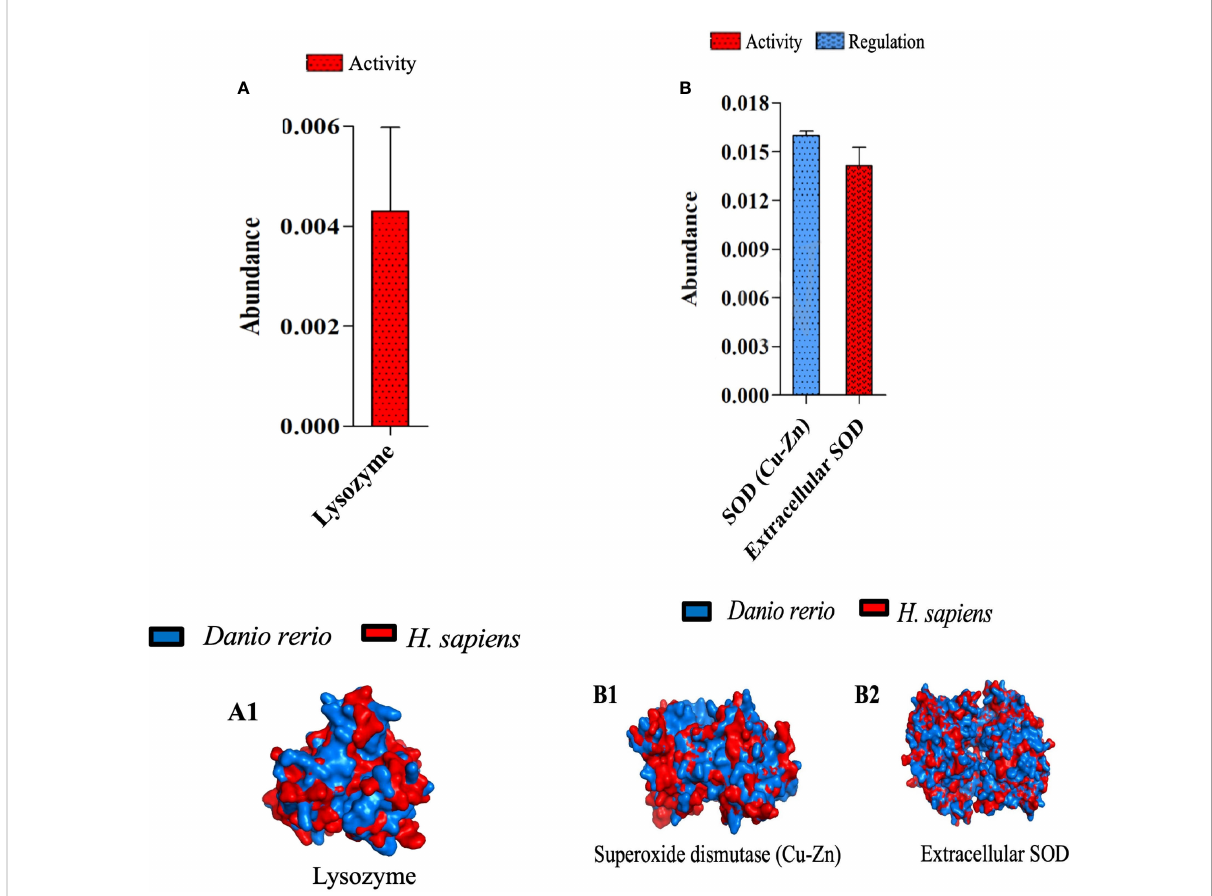
FIGURE 8 Characterization of three zebra fi sh orthologues of human catalytic enzymes participating in in fl ammatory processes mediated by l -CGN. (A) The abundance of the intra- and extra-cellular superoxide dismutase (SOD) production and its role in zebra fi sh physiology, 4h post-injection with 3.5% l -CGN. (A 1-2) Representations of the structural 3-D proteins in zebra fi sh (blue) plasma overlapping with their predicted Homo sapiens (red) homologous structures. (B) the abundance of the Lysozyme activity following the same setting as for SOD. (B 1) 3-D protein in zebra fi sh (blue) plasma overlapping with its predicted Homo sapiens (red) homologous structure. The values in the graphs are expressed as relative abundance of the sample average (n = 4). The structural analysis was obtained as described in the